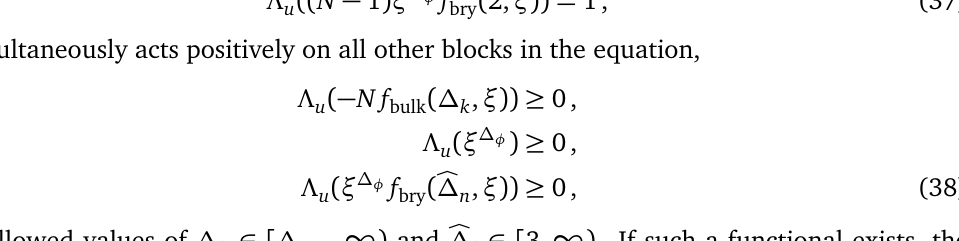
Figure 5: One-parameter family of solutions in the ( 5,3 ) truncation for N = 2. We label the bulk channel operators as ( ∆ ε , ∆ ε (cid:48) , ∆ from the literature (table 1).The solution from the ( 4,3 ) truncation is marked with a crosshair of dashed lines. The red point in the bottom left corner is a solution that has negative µ , which is not t